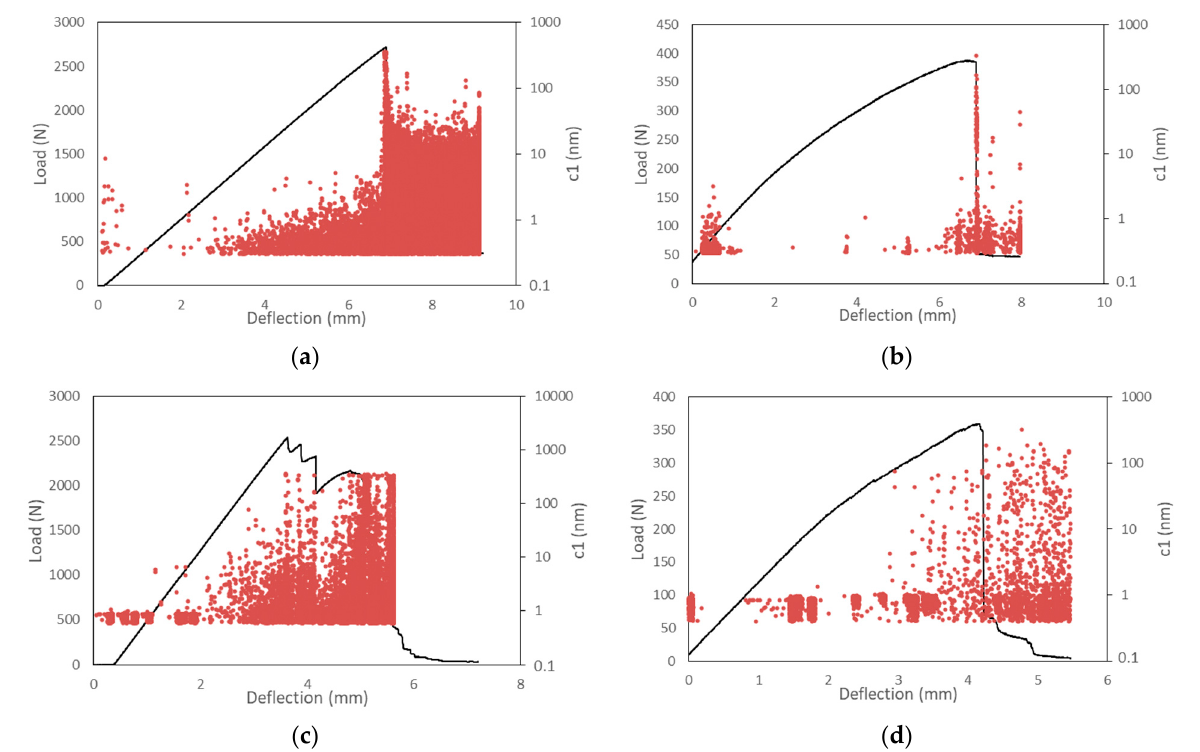
Figure 3. Load-deflection curve with peak amplitude values for GFE and flax biocomposite specimens: ( a ) GFE, room temperature, ( b ) flax biocomposite, room temperature, ( c ) GFE at the temperature of − 80 °C, and ( d ) flax biocomposite at the temperature of − 80 °C. Table 3. Flexural properties of flax and GFE composites at room temperature and at − 80 °C.